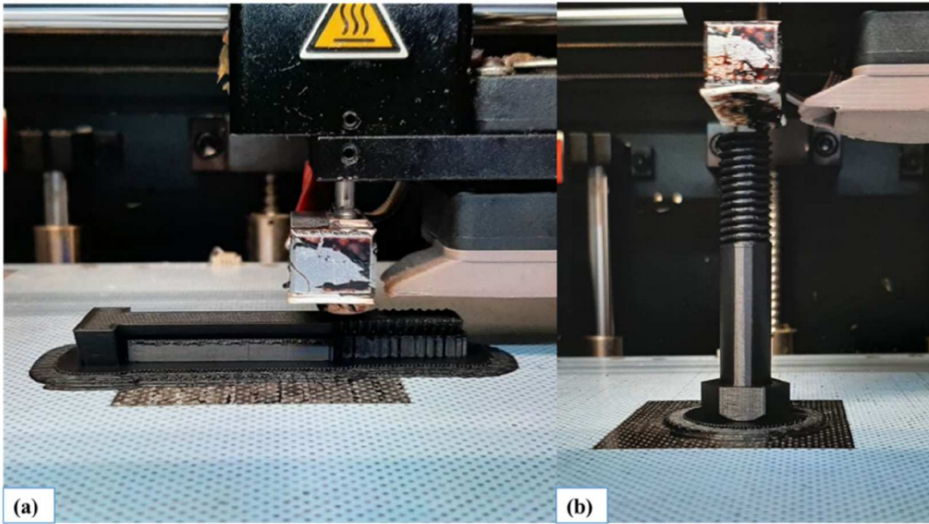
Figure 1. Printing method: ( a ) horizontal printing, ( b ) vertical